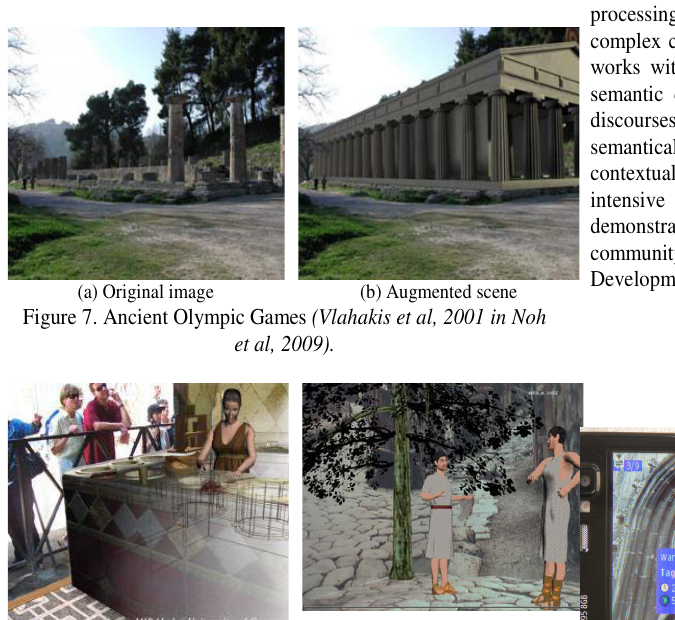
Figure 8. Ancient Pompeii (Magnenat-Thalmann et al, 2006).